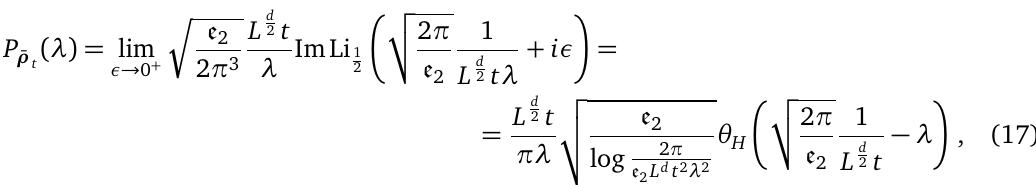
Figure 1: The asymptotic probability distribution of the eigenstates of the time aver- aged state in the limit of large volume; Ω = ε t